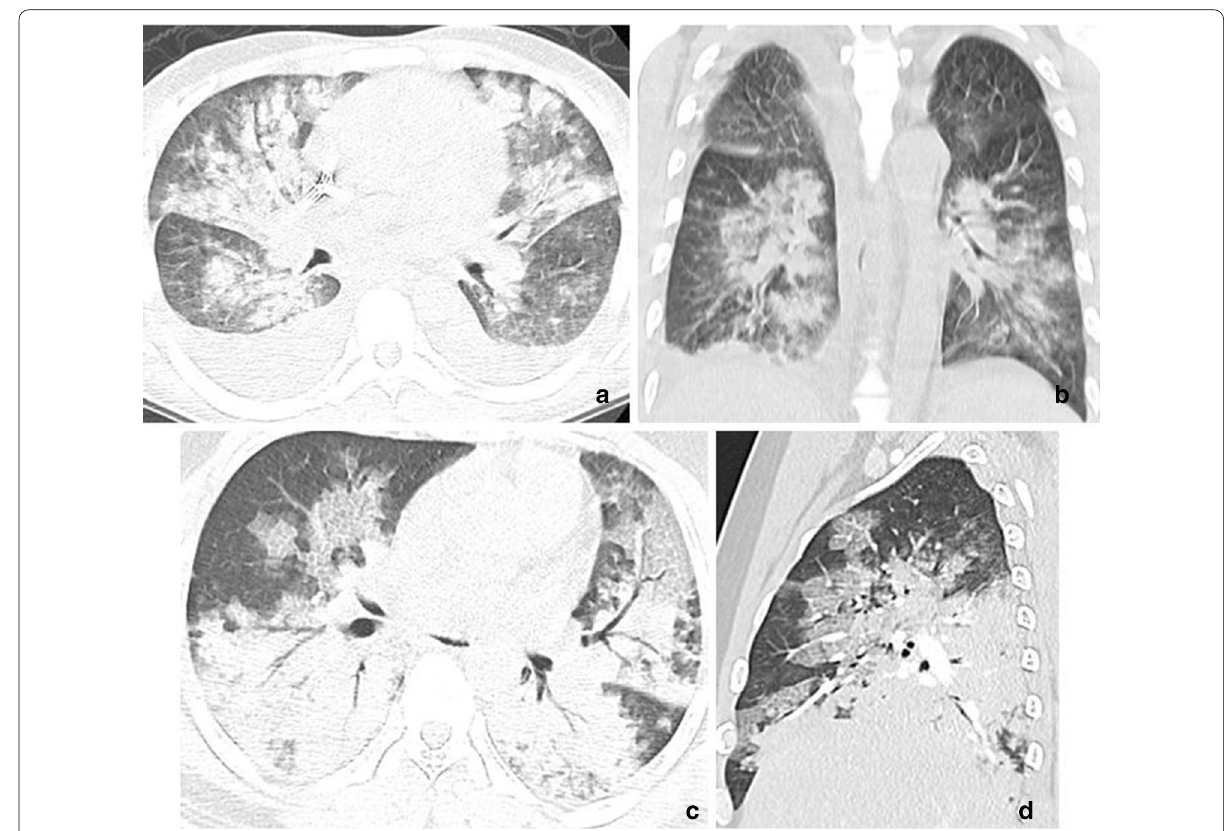
Fig. 9 Non‑infectious mimickers of indeterminate COVID‑19. a , b A 73‑year‑old man with pulmonary edema, axial and coronal reformatted CT images show bilateral perihilar consolidation and to less extent GGO associated with bilateral pleural effusion and pericardial effusion in mediastinal window (not shown). c , d A 58‑year‑old woman with acute respiratory distress syndrome, axial and sagittal reformatted CT images shows dependent consolidation and multifocal non‑rounded GOO superimposed with interlobular septal thickening (crazy